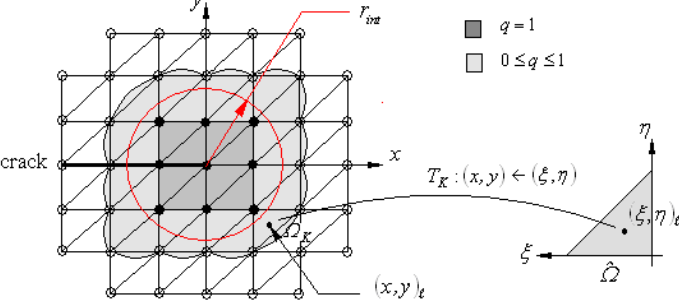
Figure 4. A crack tip-originated circle and a graded domain of integration A .